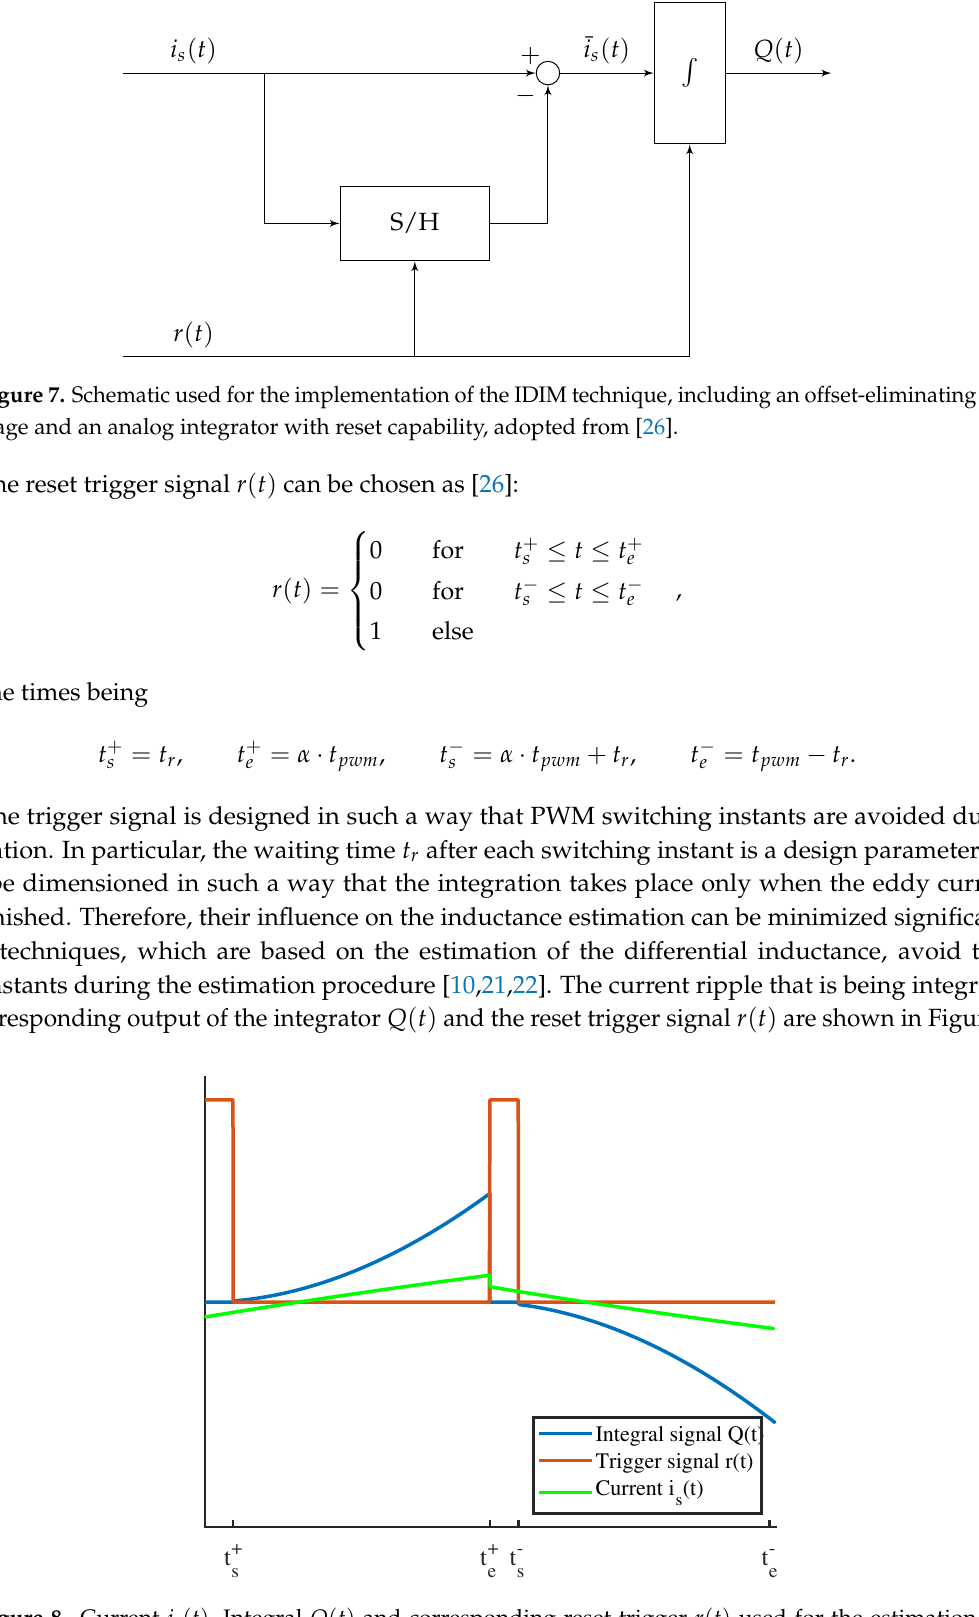
Figure 8. Current i s ( t ) , Integral Q ( t ) and corresponding reset trigger r ( t ) used for the estimation of the differential inductance L d by means of the Integrator-Based Direct Inductance Measurement (IDIM)